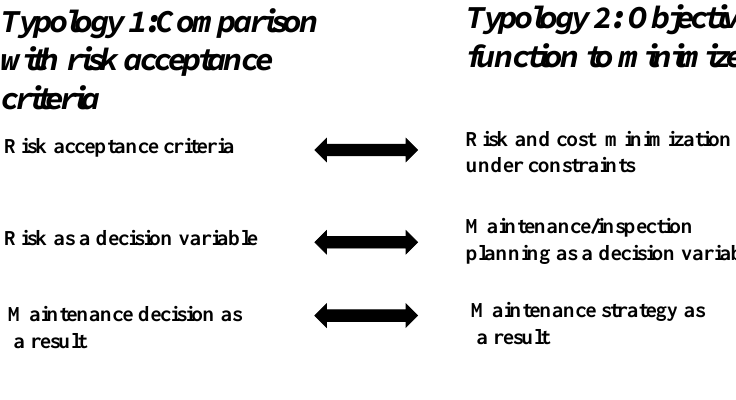
Figure 1. Main typologies for cost/risk minimization in maintenance